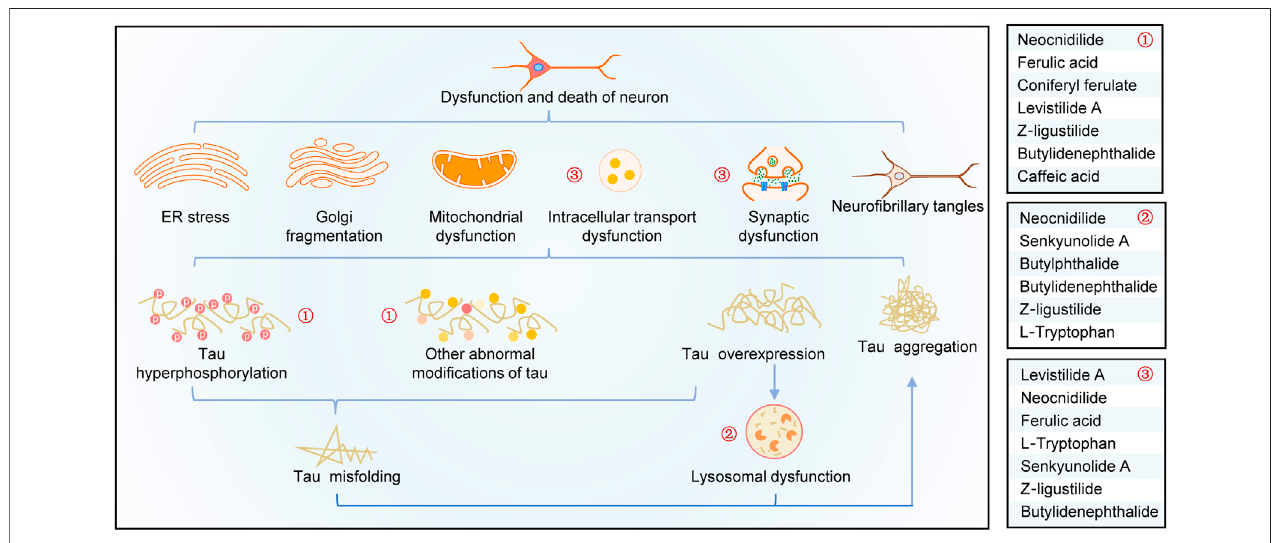
FIGURE 6 | Schematic diagram of the mechanisms of CR treatment of AD based on tau pathogenesis. CR phytochemicals related to the modi fi cation ( ① ), degradation ( ② ), and toxicities ( ③ ) of tau.